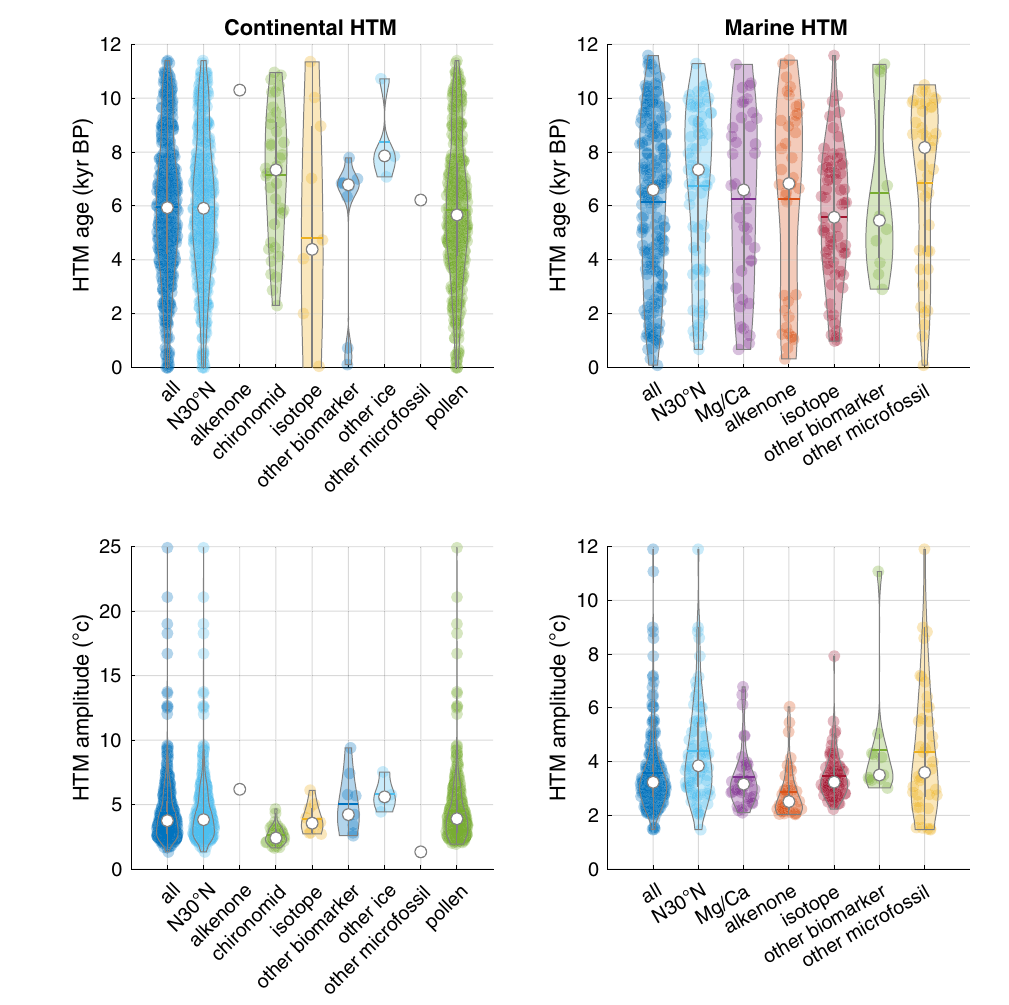
Fig. 7 | Median HTM ages and amplitudes. Median HTM ages and median HTM amplitudes for marine and continental records depending on the proxies used. Other microfossils include dinocysts, planktonic foraminifera, diatoms and radi- olaria; other biomarkers include TEX 86 , GDGTs, BNA15, LDI (see details in ref. 3).